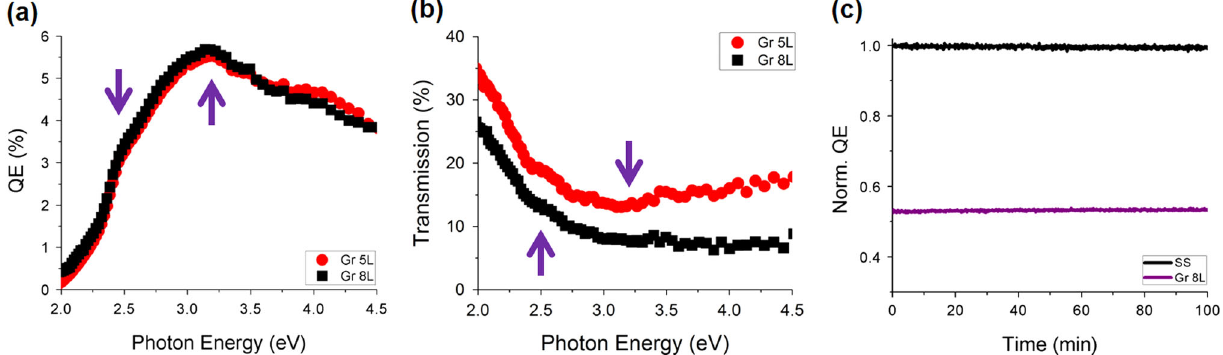
Fig. 3 a QE spectral response, b Optical transmission, c Stability of K 2 CsSb PCs deposited on graphene substrates. For a and b , red circles and black squares are for the PCs on 5 and 8-layer graphene substrates, respectively. Purple arrows indicate the regions with signature features. Black line in c is for a PC on SS substrate as a reference, and purple line is for PC on 8-layer graphene substrate. QE is normalized in c to the PC on SS